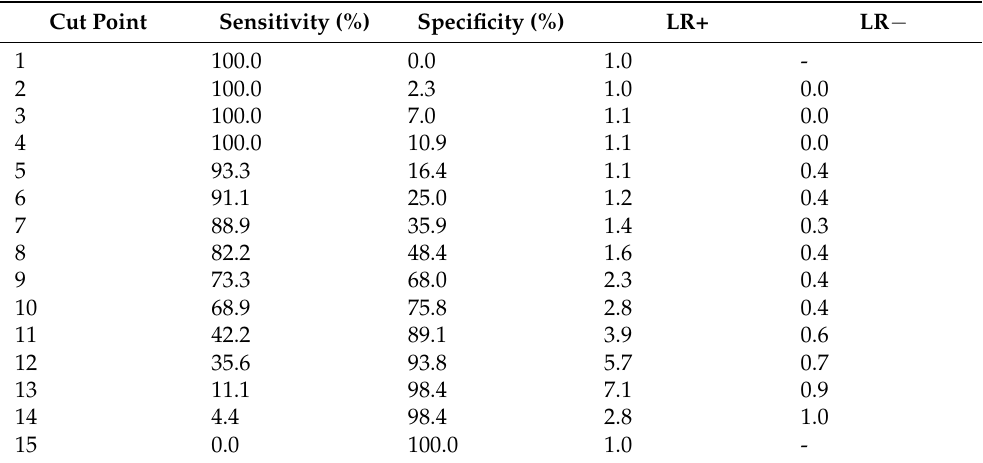
Table 6. Indices of the validation of clinical prediction rule for failed reduction of intussusception against various CMUI score cut points.